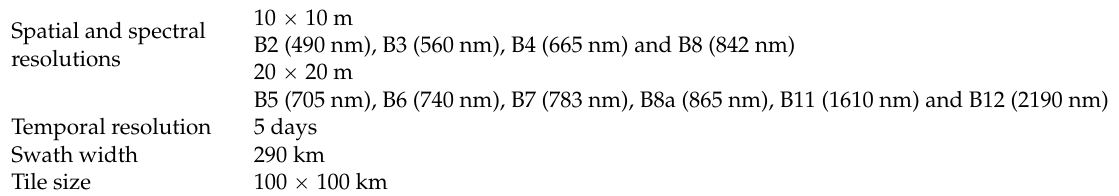
Table 2. Main characteristics of Sentinel-2 L1C/ L2A images